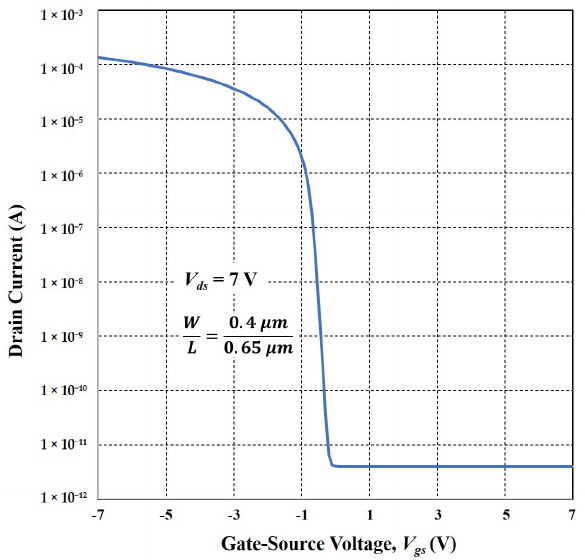
Figure 3. Transfer curve of a PMOS transistor used in the simulation.